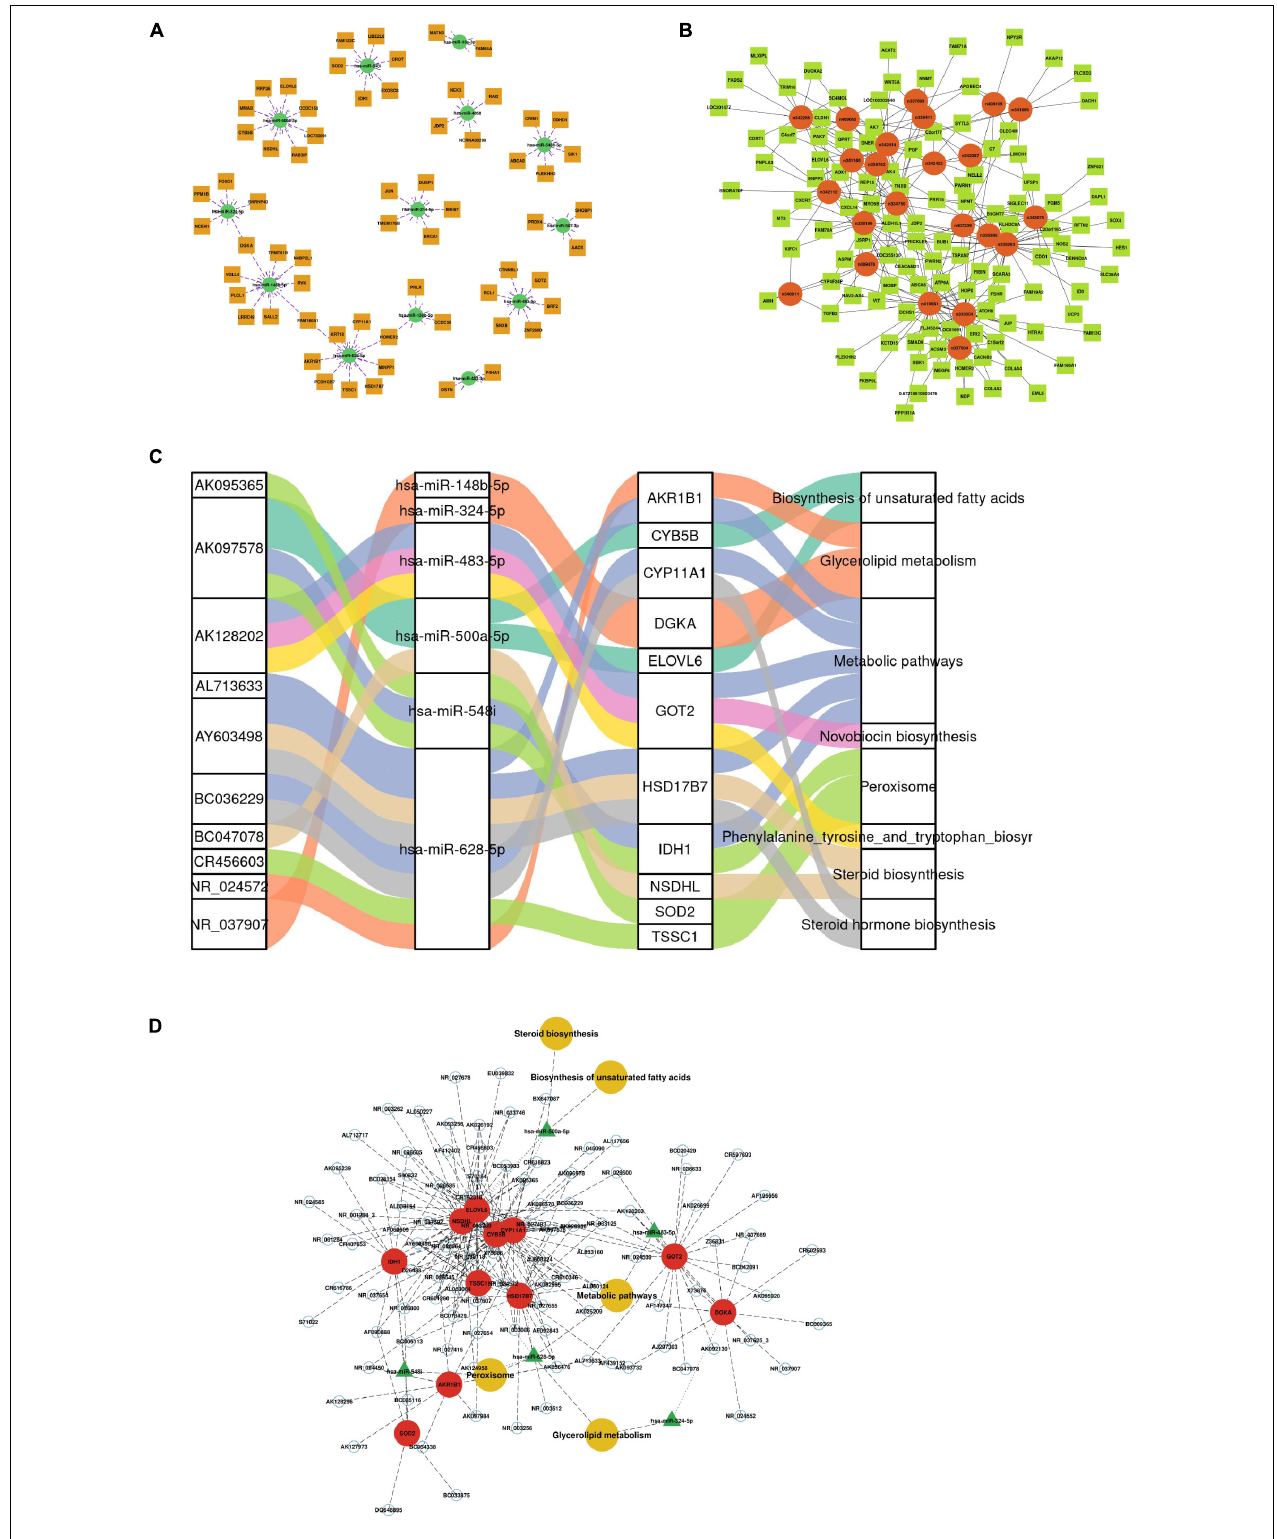
FIGURE 3 | Construction of the competing endogenous (ceRNA) regulatory network. (A) miRNA-mRNA interaction network. (B) lncRNA-mRNA coexpression network. (C) Sankey diagram of integrative network analysis of multi-RNA-seq data. (D) ceRNA interaction network of miRNA-mRNA-lncRNA interactions. This plot shows the potential regulatory linkage of different RNAs and biological pathways. The four modules represent lncRNAs, miRNAs, mRNAs, and pathways.